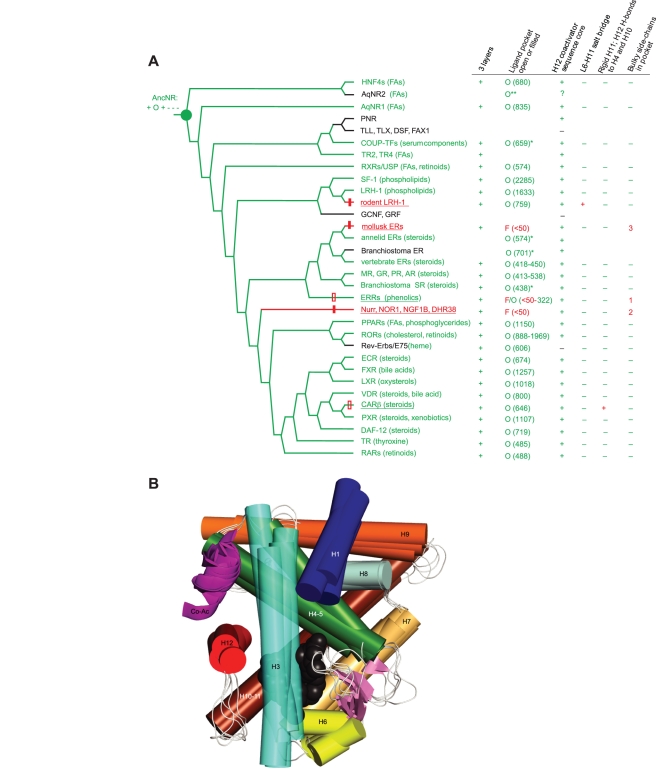
Ancient origin of ligand-activation in the NR superfamily.(A) Reconstruction of structural and functional characters on the NR phylogeny. Ligand-regulated transcriptional activators are shown in green, with ligands in parentheses. Red, activators with no known ligand. Underlined, receptors with transcriptional activity in the absence of ligand or other modifications. Black, repressors that do not activate transcription. The ancestral NR (AncNR, green circle) is shown, with the most parsimonious reconstructions at that node for the characters in the table. Hash marks on branches show gains of ligand-independent activity with or without loss of ligand binding (filled and empty red boxes, respectively). States of protein structural characters are shown in the table. “3 layers”: 10 to 12 helices arranged in conserved three-layer sandwich as in panel B. “Ligand pocket open or filled”: O, open internal cavity bounded by helices 3, 5, 7, 10, and 12 in crystal structure (cavity volume in Å3); O*, open pocket in homology model; O**, open pocket inferred from experimental data on ligand-binding or ligand-regulation; F, filled cavity, <50 Å3. “H12 coactivator sequence”: presence (+) or absence (−) of canonical co-activator interface φφ*κφφ motif in helix 12 (φ, hydrophobic; *, any residue; κ, charged). “L6-11 salt bridge”: presence (+) or absence (−) of salt bridge from the L6-7 loop to helix H10-11. “Rigid HX and H10-H12 h-bonds”: presence (+) or absence (−) of short additional helix N-terminal to H12 and hydrogen bonds between H10-11 and H12. “Bulky residues in pocket”: presence (1,2,3) or absence (−) of Phe or Trp residues in space occupied by ligand in other receptors; 1, 2, 3 indicate bulky residues at different sets of sequence sites (see Figure 6). Blank cells, no data available. Rodent LRH-1 has been coded as a ligand-independent activator based on its crystal structure, but functional assays have not established its ligand-independence. (B) Shared structural basis for ligand-dependent activation in NR LBDs. The peptide backbones and ligands are superimposed for five distantly related NRs: human HNF4α, mouse RXRα, human ERα, mouse RARβ, and human PPARα. Gray spheres show ligands. Helices (shown as cylinders) are numbered, and the coactivator peptide (Co-Ac) is a magenta ribbon. The beta-sheet between H5 and H6 is pink. The region between H1 and H3, which is structurally variable, has been removed to show the ligands more clearly. For details and PDB identifiers, see Tables S4, S5, and S7.